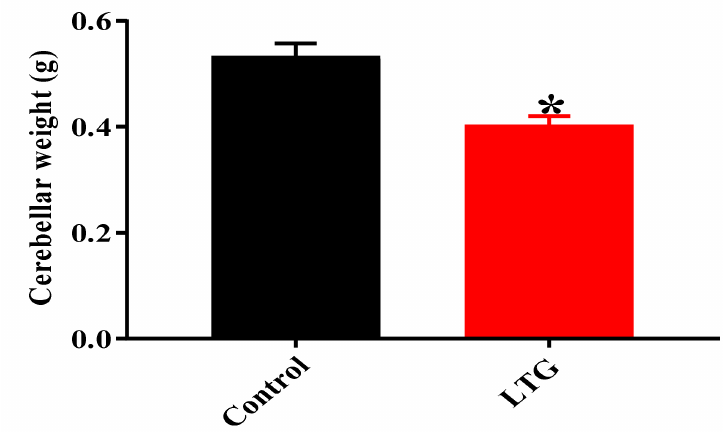
Figure 9. E ff ect of Pb acetate on cerebellar weights of rats of the control group and LTG. Data are represented as mean ± SEM ( n = 6); * p < 0.05 vs.